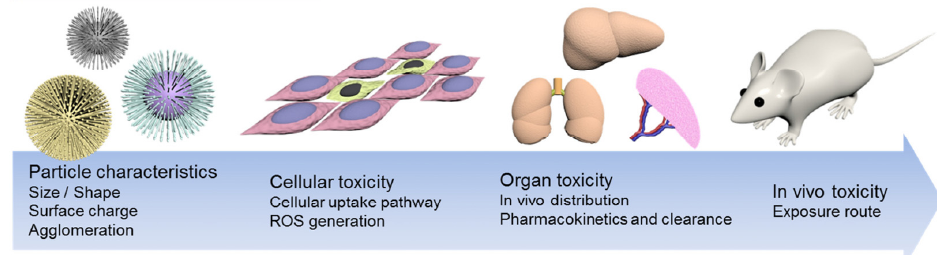
Figure 1. Illustration of the main properties of nanoparticles. Adapted from [68]. Open access.